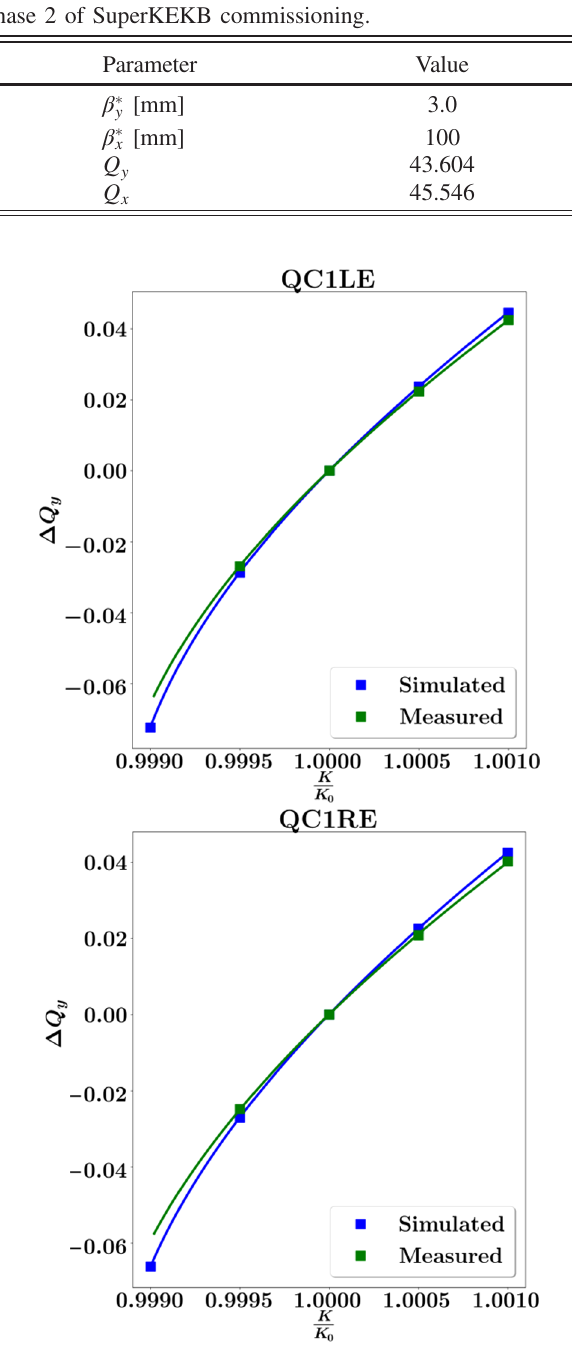
FIG. 11. Simulated and measured tune shift when modulating the inner quadrupoles in HER. The simulations are done using the design optics with β (cid:1) y ¼ 3 mm. The uncertainty in the recorded tune measurements are 4 × 10 − 4 for the modulation of the QC1LE magnet and 2 × 10 − 4 for the modulation of the QC1RE magnet. The lines have been made by fitting the average β function and using Eq. (3). The integrated strength of the magnets during the measurements were KL 0 ¼ − 1 . 15 m − 1 for QC1LE and KL 0 ¼ − 1 . 09 m − 1 for